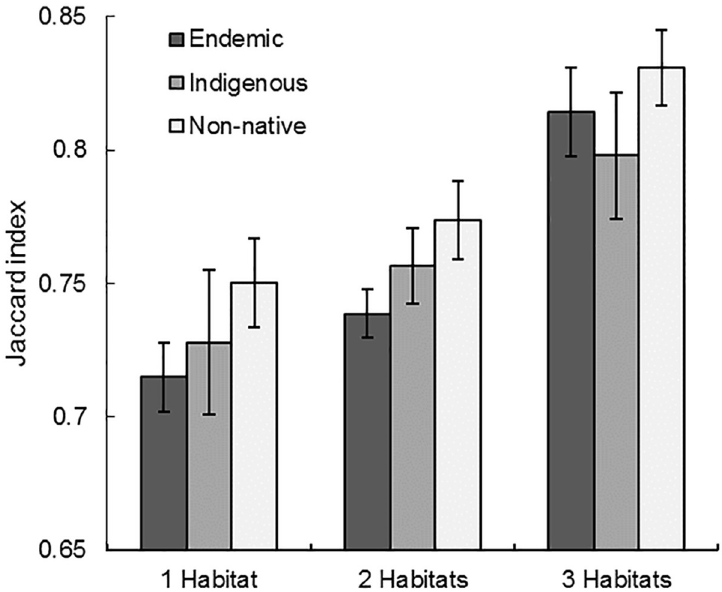
Fig 4. Species specialization by number of habitat moisture types. Plant species ranked as generalists (higher Jaccard index values) occur in more habitat moisture types (dry, mesic, wet) as hypothesized according to the published Hawaiian plant literature, than those limited to a single habitat moisture type ( p < 0.001; Table 5). Mean values and standard errors are reported.